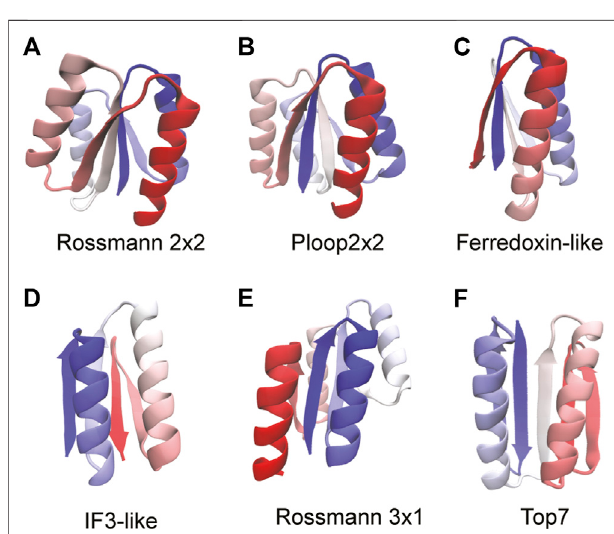
FIGURE2| ProteinsusedtobenchmarktheRPmethodareshown.The proteins are colored from blue (N-terminus) through white to red (C-terminus). Thefoldsoftheproteinsarestatedbeloweachstructure.Wementionherethe sequence of secondary structural elements for each fold. (A) Rossmann 2x2: β - α - β - α - β - α - β - α . (B) P-loop 2x2: β - α - β - α - β - α - β - α (C) Ferredoxin: β - α - β - β - α - β (D) IF3: β - α - β - α - β - β (E) Rossmann 3x1: β - α - β - α - β - α - β - α (F) Top7: β - β - α - β - α - β - β .AllproteinstructuresaredrawnusingtheprogramVMD(Humphrey et al., 1996). Proteins that have the same sequence of secondary structural elementsfoldtodifferenttertiarystructuresandthiscanbeseenbycomparing (A) , (B) , and (E)